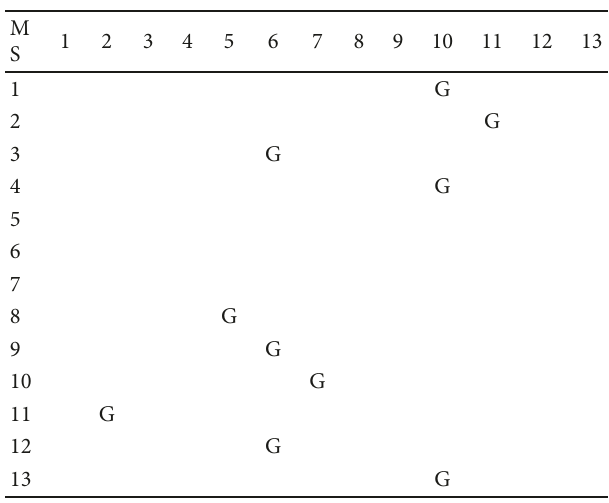
Table 2: Contact table of 13 contact bodies.